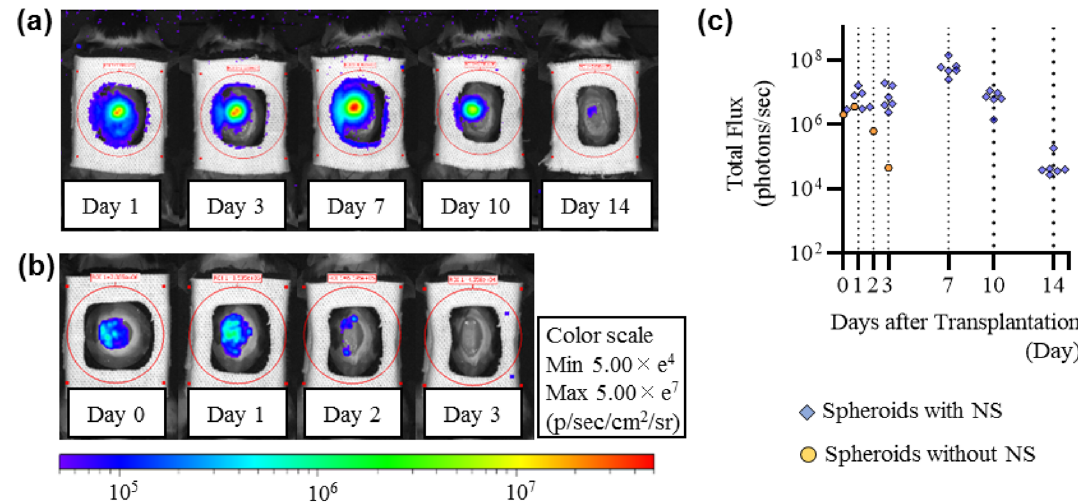
Figure 2. Images of luminescence from ASC spheroids. ( a ) Time-lapse images of luminescence from ASC spheroids carried by the nanosheet (representative images). The luminescence peaked at day 7 and was observed for 14 days. ( b ) Time-lapse images of luminescence from ASC spheroids that were simply dropped onto the wound (no nanosheet) (representative images). The luminescence decreased gradually and was observed for only 3 days at most. ( c ) Transition of intensity of luminescence from ASC spheroids carried by the nanosheet ( blue rhombuses ) and ASC spheroids without a nanosheet ( yellow circles ) after transplantation.